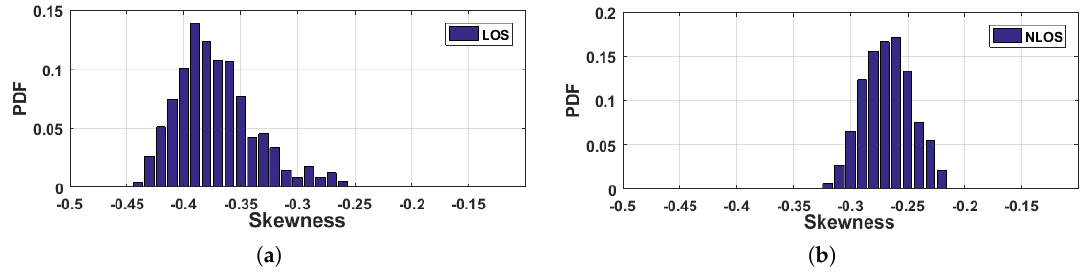
Figure 12. The distribution of CIR skewness under ( a ) LOS and ( b ) NLOS conditions.